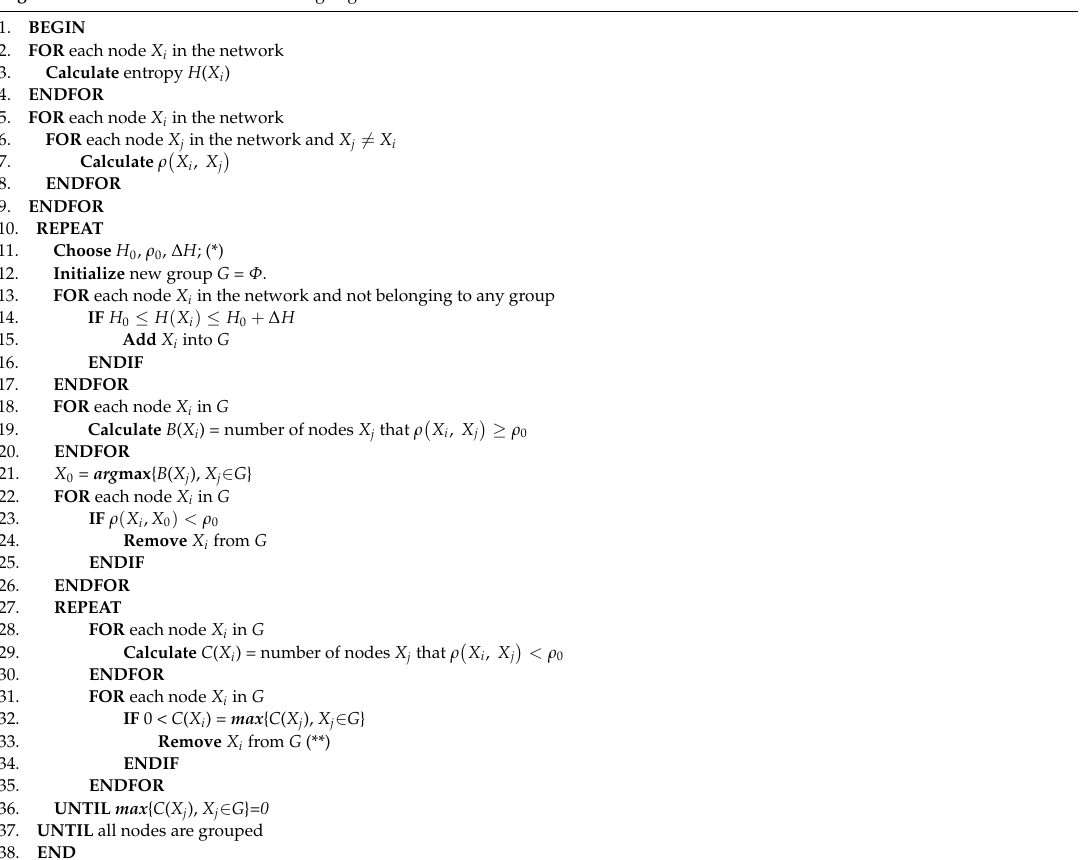
Algorithm 1 : Correlation-based Clustering